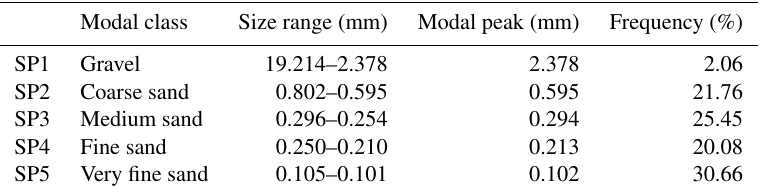
Figure 2. RPAS on flight on the surveyed beach. Table 1. Frequency distribution for each modal class of the sample. Modal